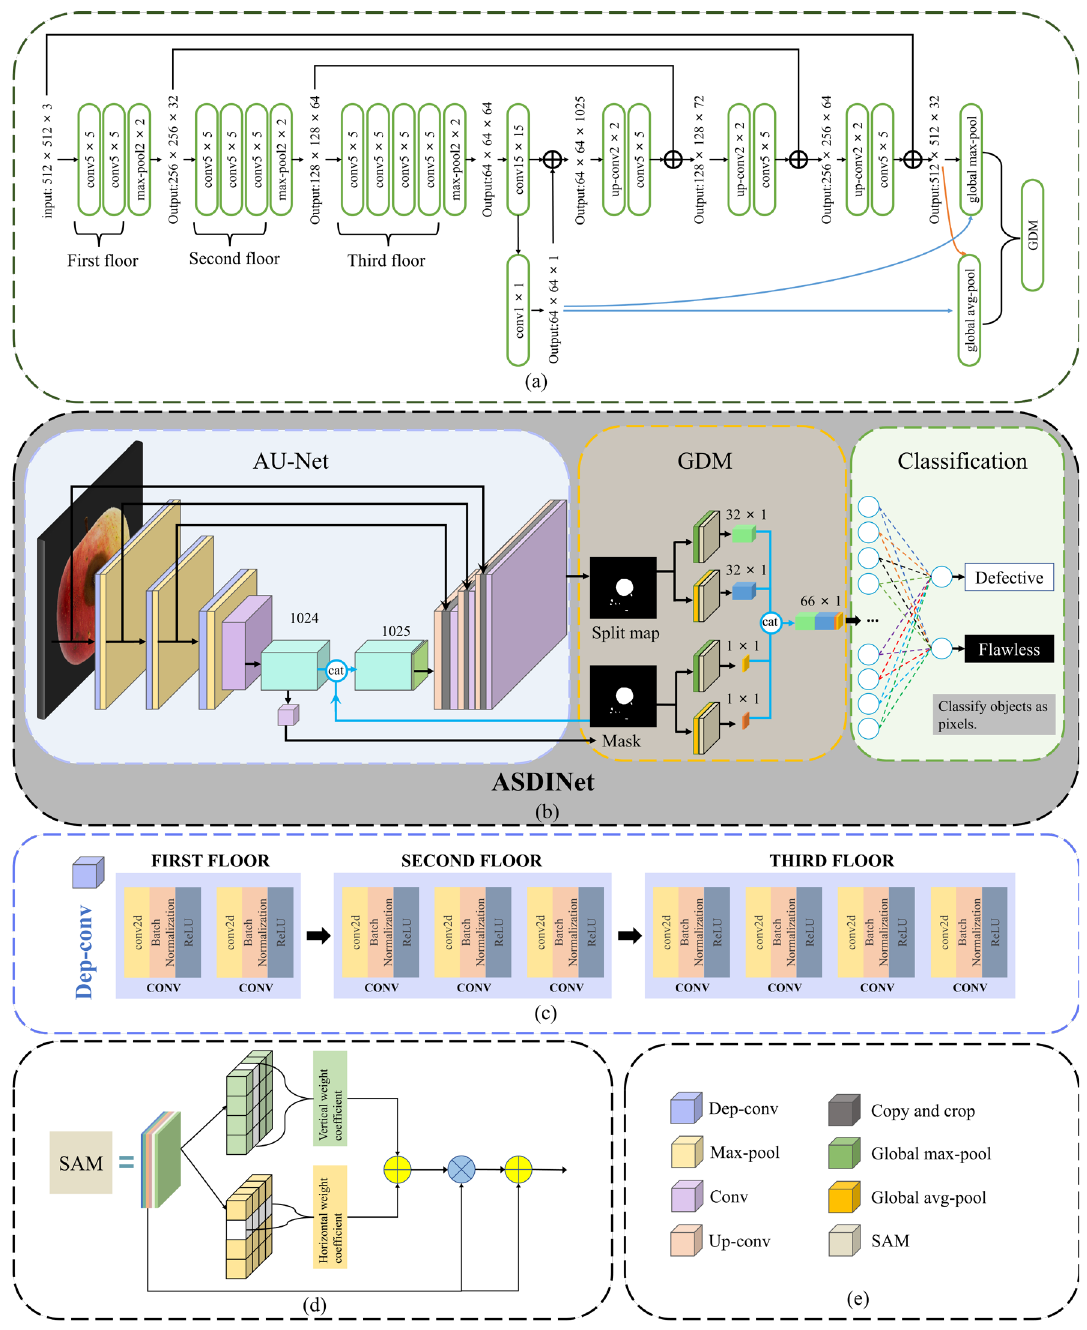
Figure 3. Network structure diagram: ( a ) is the structure diagram of the ASDINet; ( b ) is the network structure diagram of the ASDINet, including the AU-Net and GDM; ( c ) is a schematic diagram of the Dep-conv module; ( d ) is a schematic diagram of the GSAM; ( e ) is the meaning of the corresponding module in ( b ).